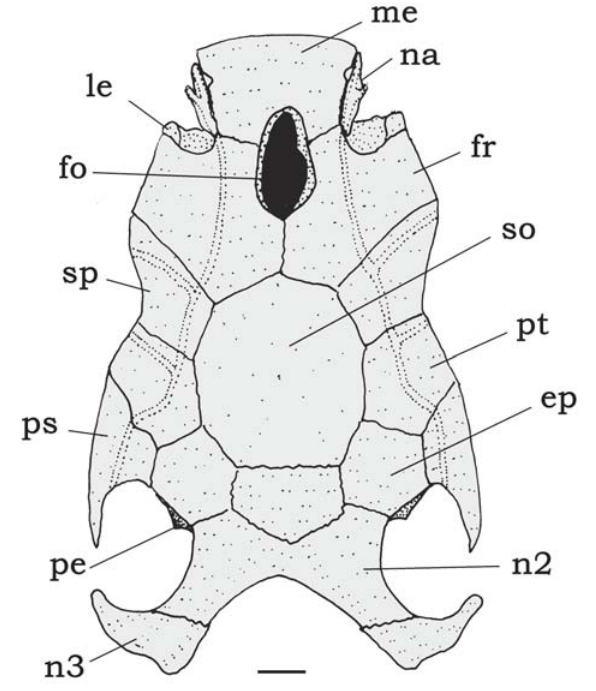
Fig. 41. Neurocranium of Tatia strigata , MZUSP 44066, 38.9 mm SL. Dorsal view. Abbreviations: ep , epioccipital; fo , single cranial fontanel, fr , frontal; le , lateral ethmoid; me , mesethmoid; na , nasal; n2 ; second nuchal plate; n3 , third nuchal plate; pe , posterior epioccipital process; ps , posttemporal- supracleithrum; pt , pterotic; so , supraoccipital; sp , sphenotic. Scale bar = 1.0 mm.